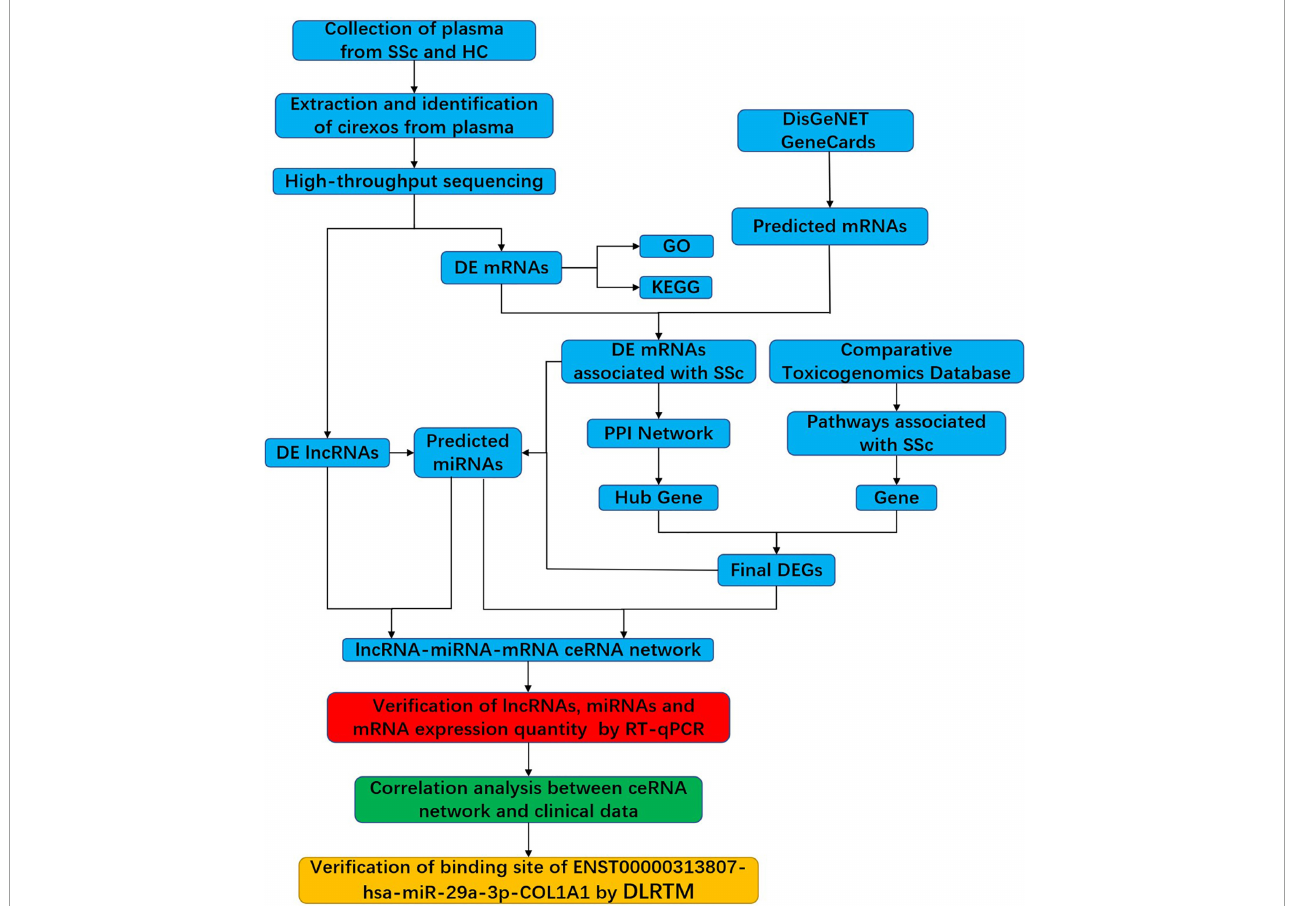
FIGURE1 Flowchart of the experimental design. SSc, systemic sclerosis; HC, healthy control; cirexos, circulating exosomes; DEmRNAs, differentially expressed mRNAs; DElncRNAs, differentially expressed lncRNAs; DEGs, differentially expressed genes; GO, gene ontology; KEGG, Kyoto Encyclopedia of Genes and Genomes; PPI, protein–protein interaction; RT-qPCR, real-time quantitative PCR; DLRTM, dual-luciferase